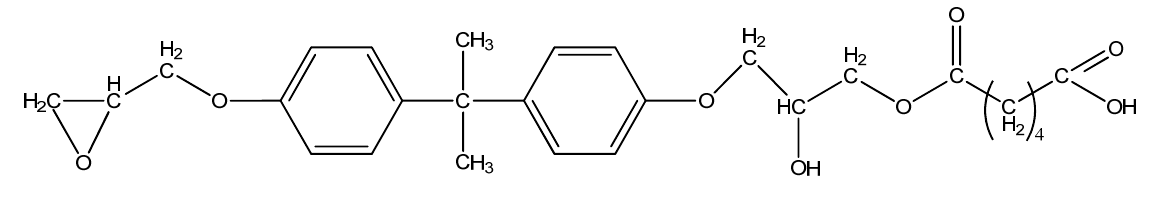
Figure 1. The chemical formula of ED-24AK.